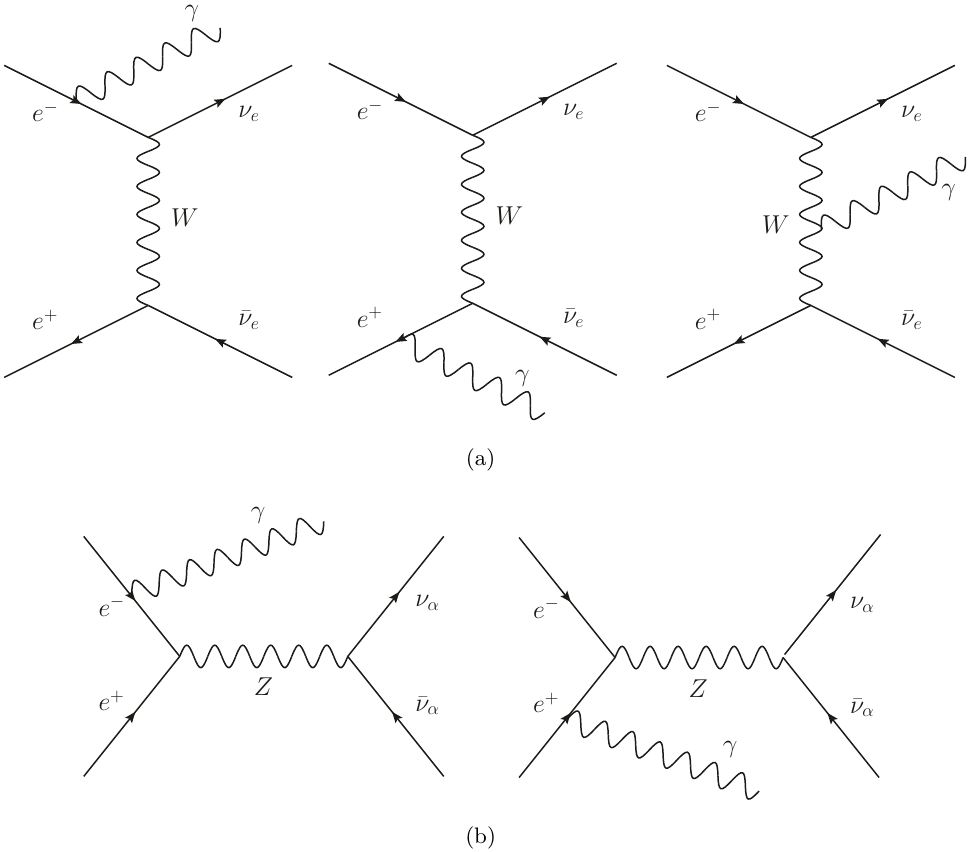
Figure 1 . Contributions to the e − e + → ν ¯ νγ process at tree level, from the W (a) and Z (b) bosons.